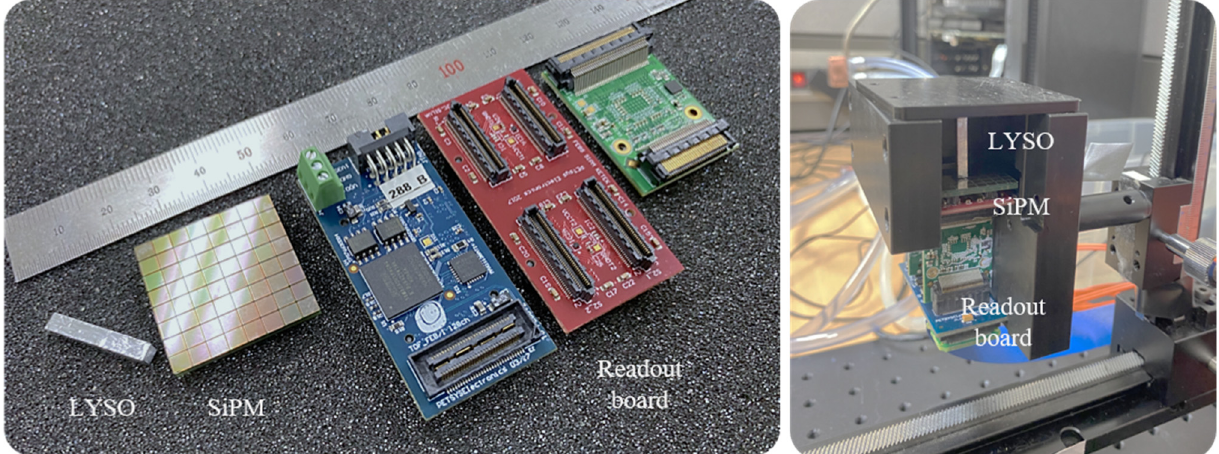
Figure 2. Detector system components (LYSO scintillation crystal (3 × 3 × 20 mm 3 ), 8 × 8 array silicon photomultiplier (SiPM), and readout board) ( left ) and experimental setup with light-tight structures ( right ).